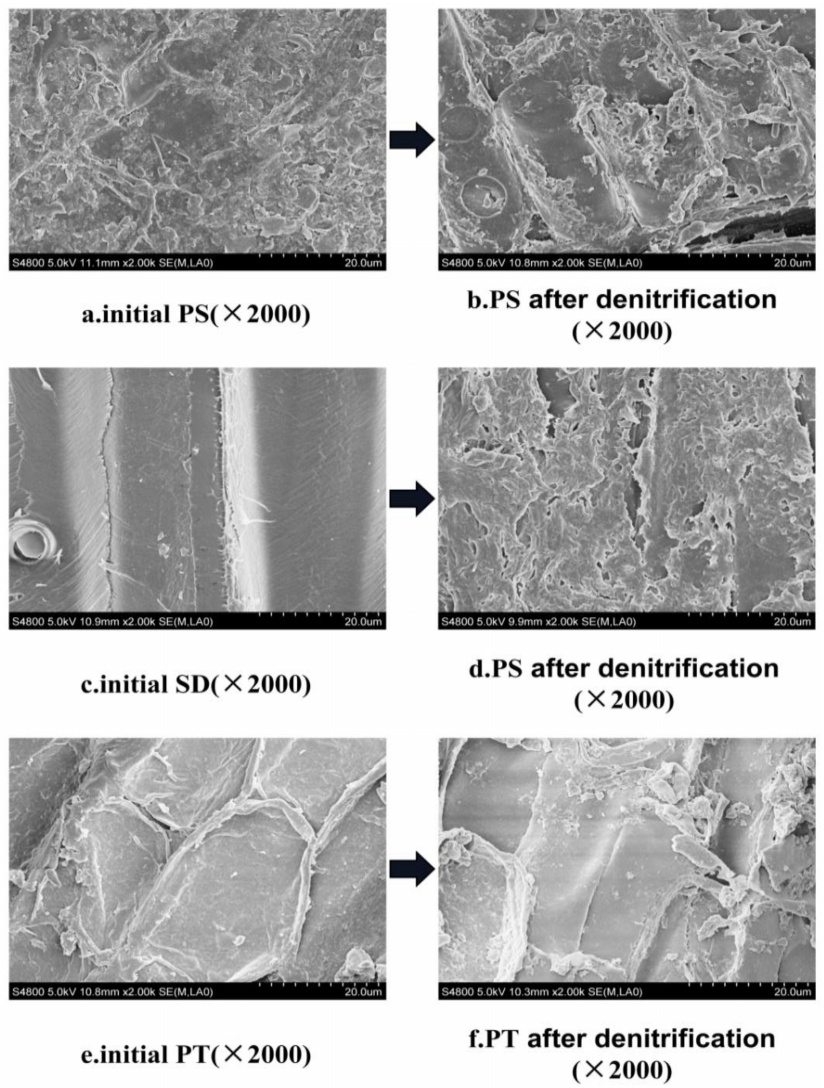
Figure 8. Scanning electron microscope (SEM) images of each carbon source before and after